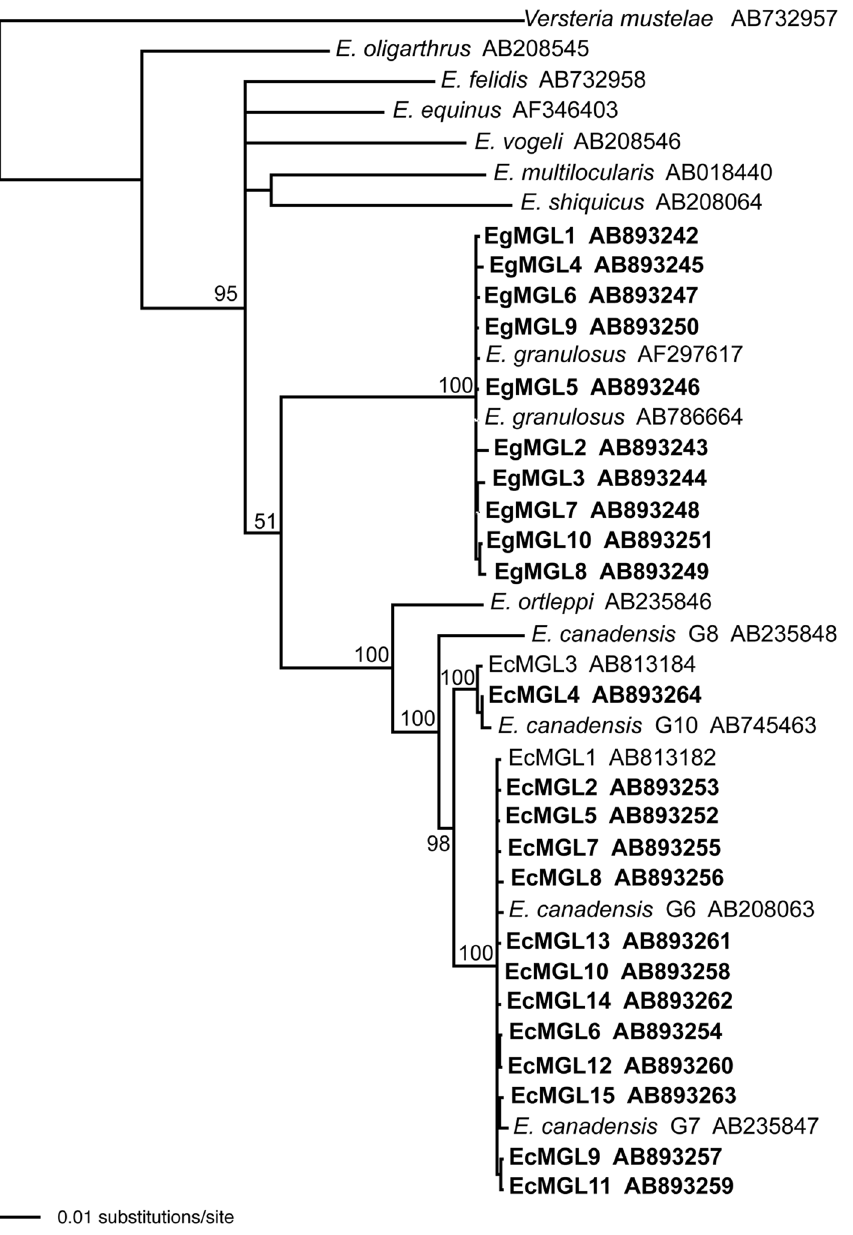
Figure 1. A neighbour-joining tree of Echinococcus spp. constructed from the nucleotide sequences of mitochondrial cox1 gene. Numbers on the nodes are bootstrap values. The names of the haplotypes obtained in this study are shown in bold.